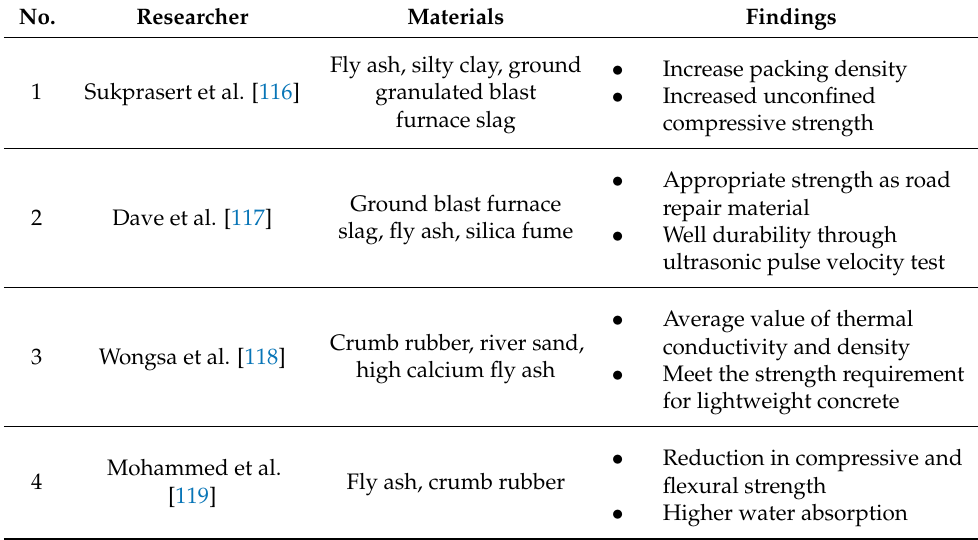
Table 5. Research work utilising geopolymers in road applications.